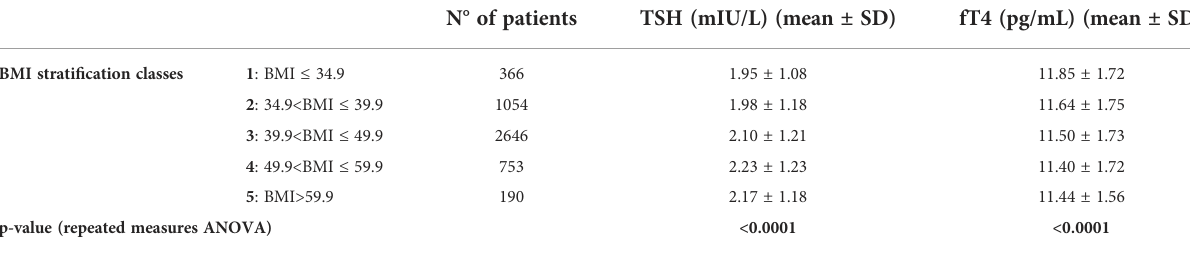
TABLE 2 TSH and fT4 levels in the study population according to BMI strati fi ed in 5 classes.